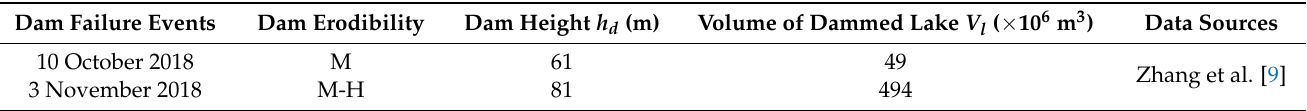
Table 4. Parameters of Baige landslide dam on Jinsha River in 2018.